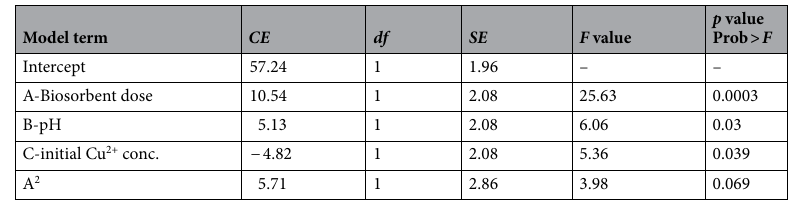
Table 3. Analysis of variance (ANOVA) for the coefficients of the quadratic model of the biosorption of Cu 2+ ions onto R. damascena . CE coefficient estimate, df degree of freedom, SE standard